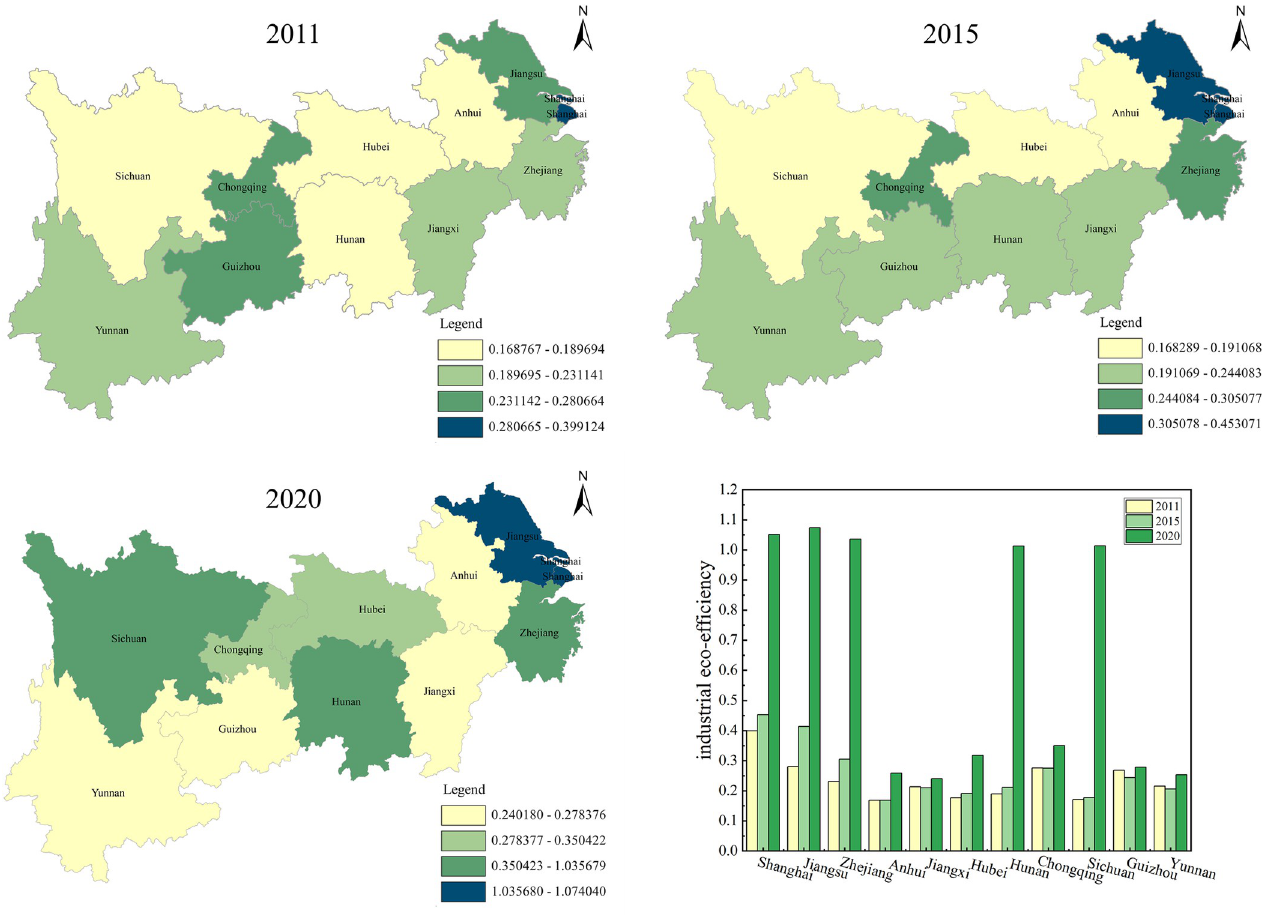
Fig 3. Regional characteristics of industrial